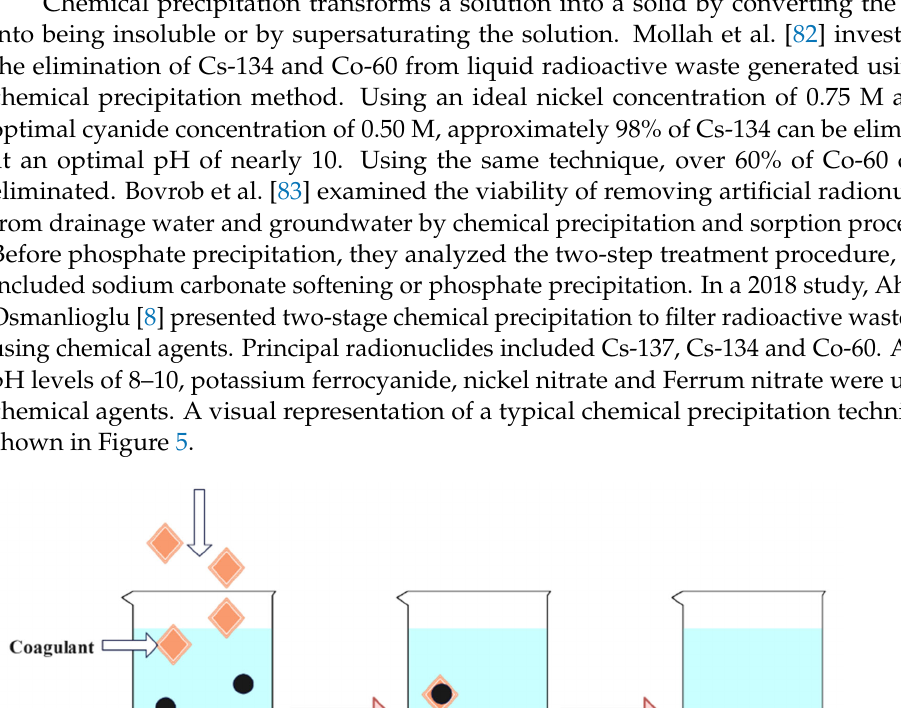
Figure 4. Membrane filtration technique [81].